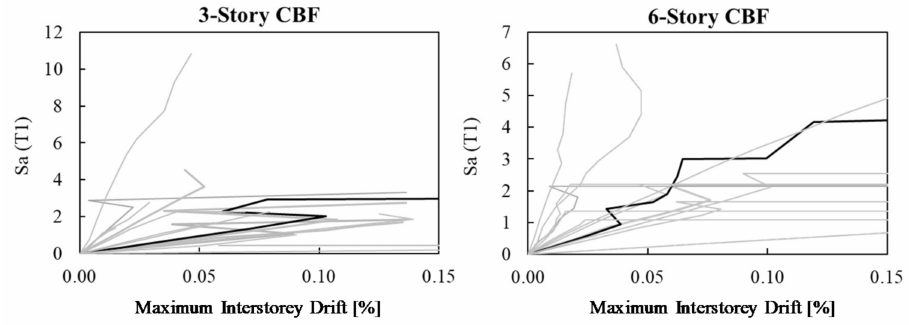
Figure 9. IDAs curves for examined